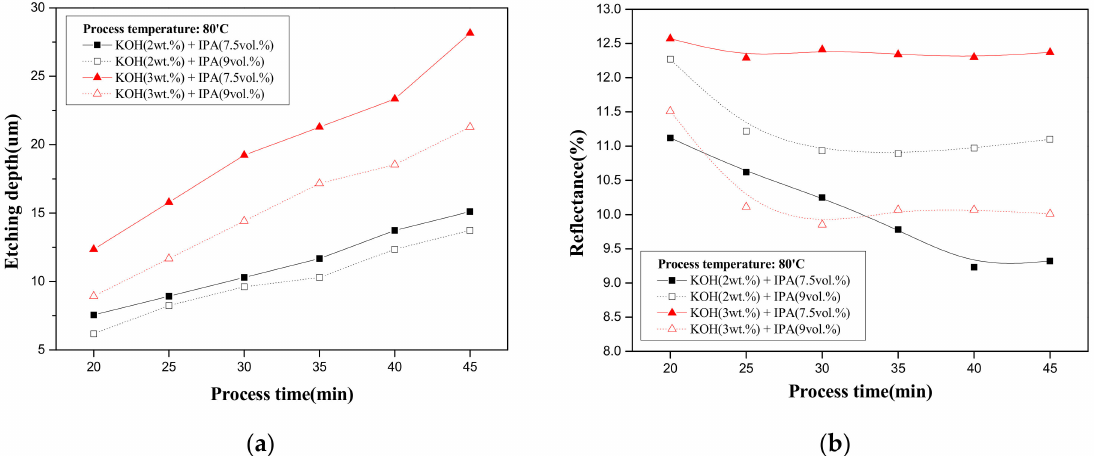
Figure 3. Characteristics of the wafer according to the KOH and IPA concentrations: ( a ) etching depth and ( b ) reflectance.